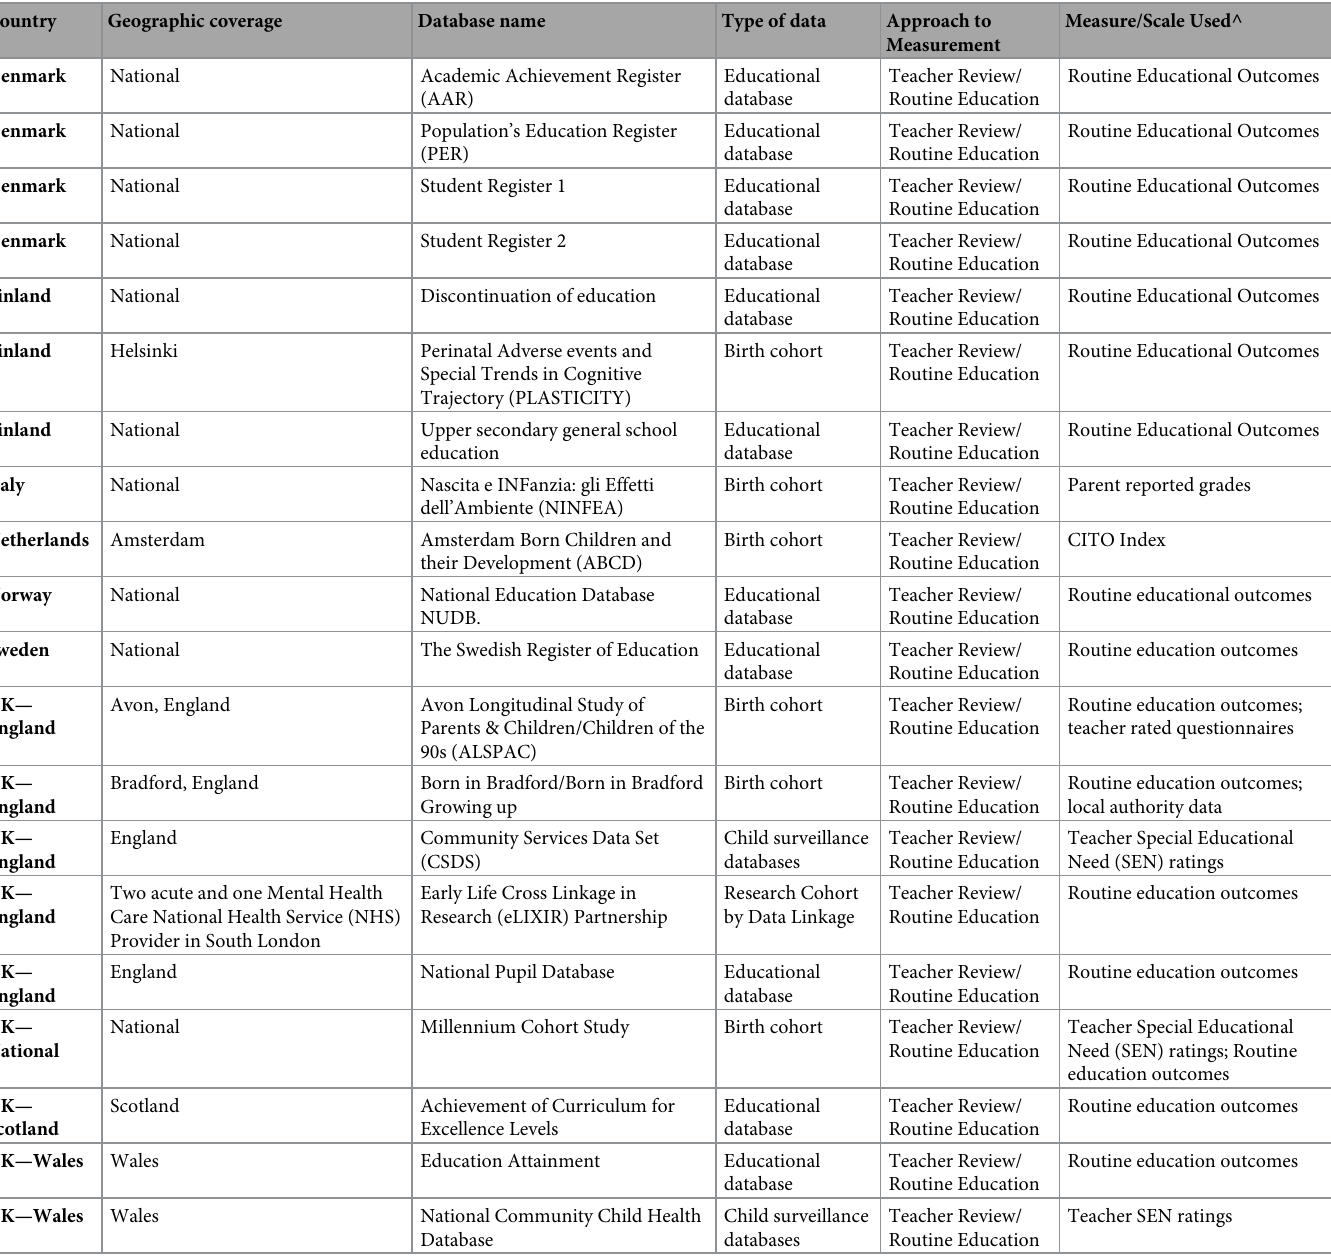
Table 4. Data sources which record educational outcomes.